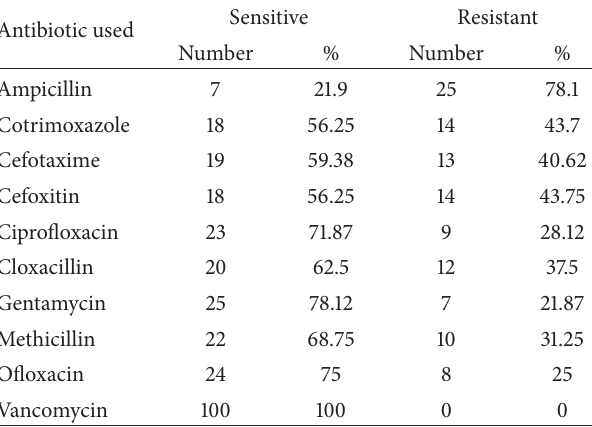
Table 4: Antibiotic susceptibility profile of S. aureus ( 𝑛 = 32